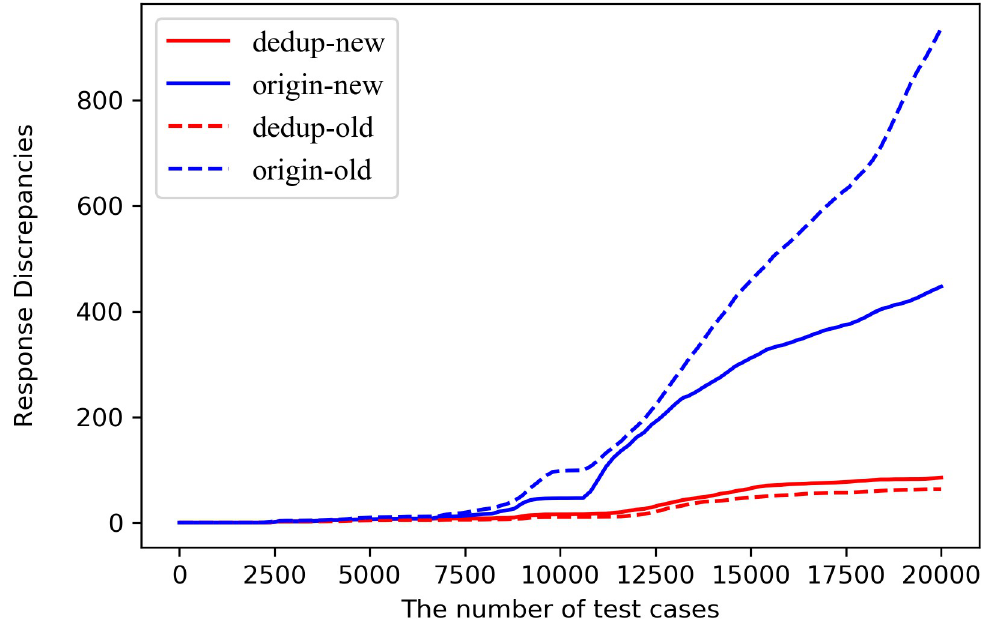
Fig 3. TLS-diff based deduplication versus no-duplication comparison. The dashed lines and the solid lines represent the implementation of old and new versions, respectively. The red lines are the number of response discrepancies after deduplication, which are lower than that of without deduplication (blue